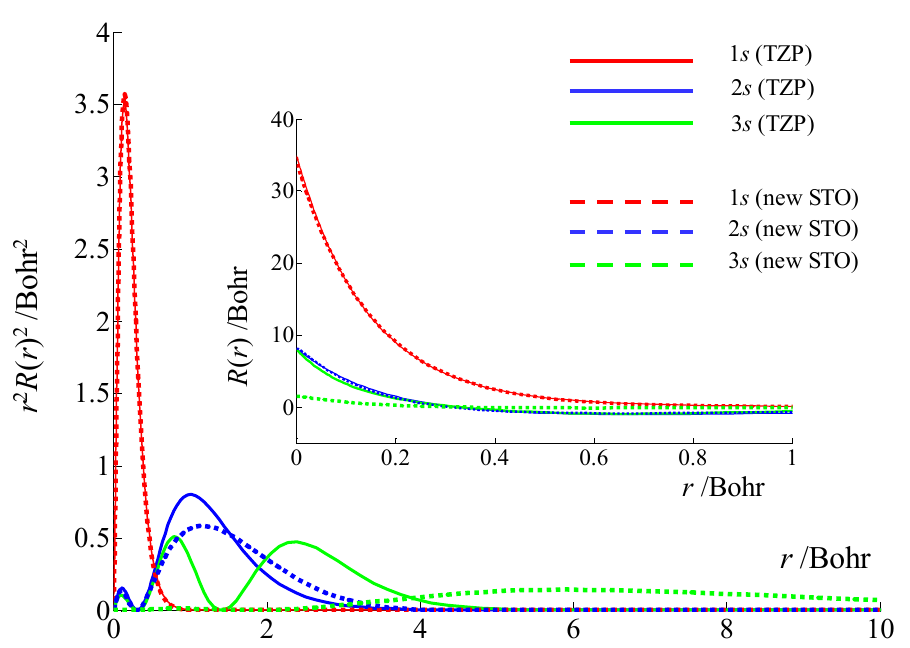
Figure 11. Radial profiles of the 1s, 2s, and 3s atomic orbitals of the nitrogen, computed with STO-type functions and BLYP (Becke-Lee-Yang-Parr) functional in the ADF code. The continuous lines correspond to the standard TZP basis, the dashed lines illustrating preliminary tests with a new basis showing long-range maxima in the r 2 R ( r ) 2 functions. The inset shows the r vs. R ( r ) variation near nucleus.